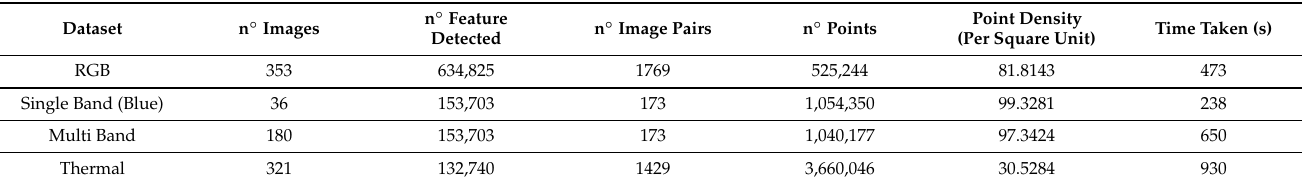
Table 4. Characteristics of data sets and their produced models.